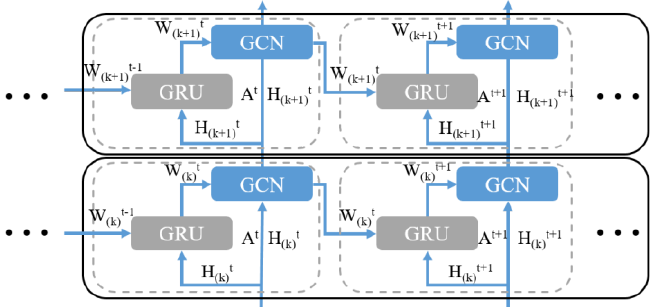
Figure 2. The framework of the dynamic graph convolution module.